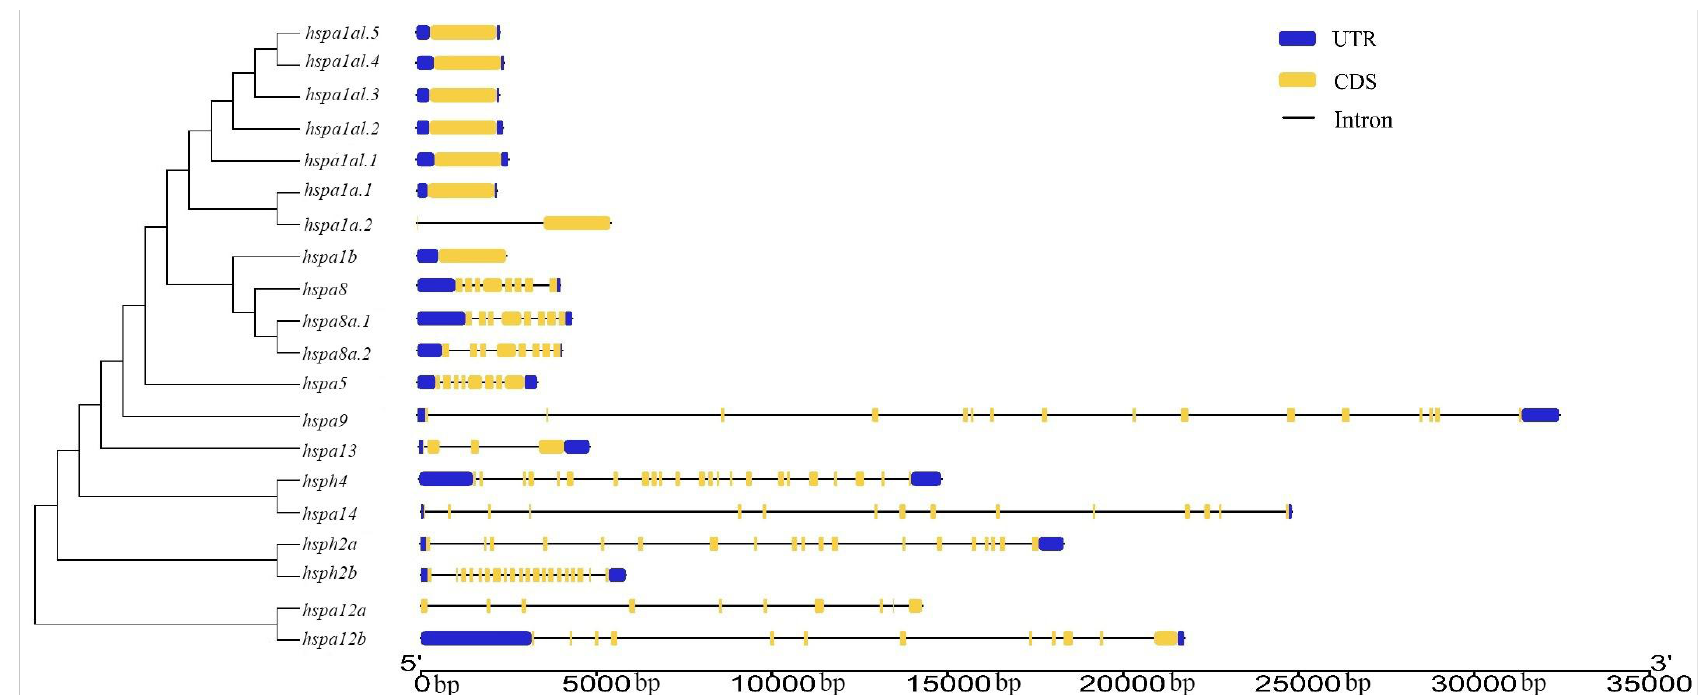
Figure 2. Gene structure analyses of B. pectinirostris Hsp70 genes according to phylogenetic relationship. The blue boxes, yellow boxes, and the black lines indicate UTR (untranslated region), exons, and introns, respectively.